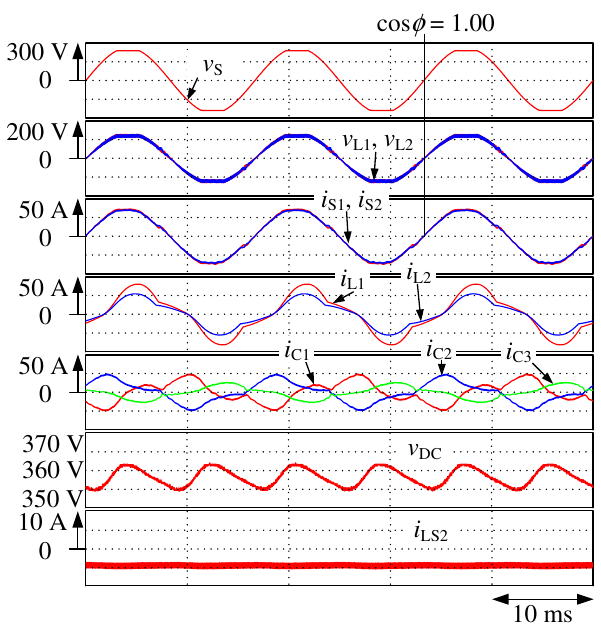
Figure 2. Simulation results for Figure 1 during battery-charging operation.